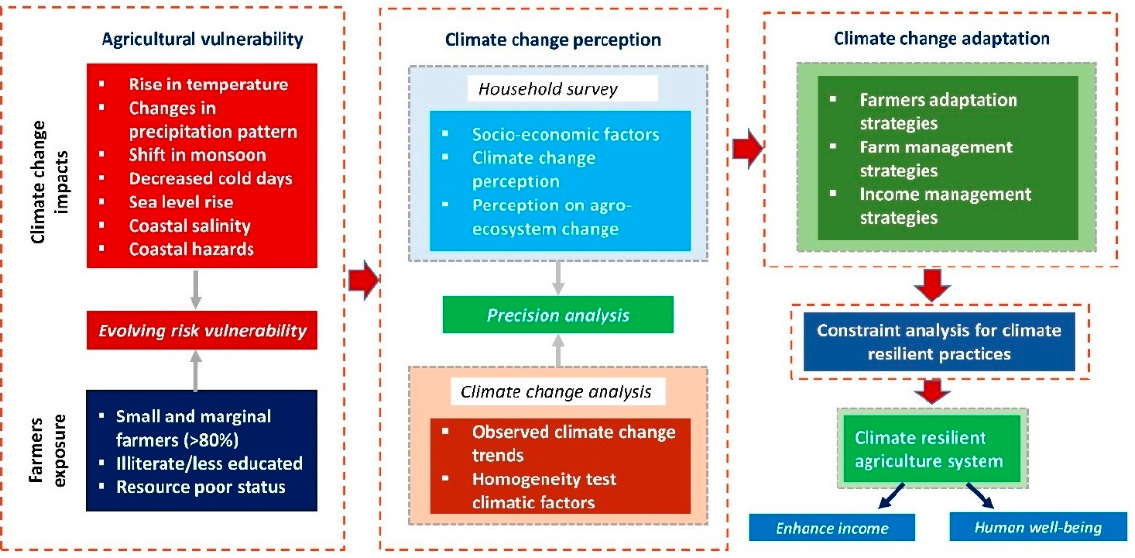
Figure 1. Conceptual framework of the present study to develop climate-resilient agriculture systems in the North Goa district, coastal India.